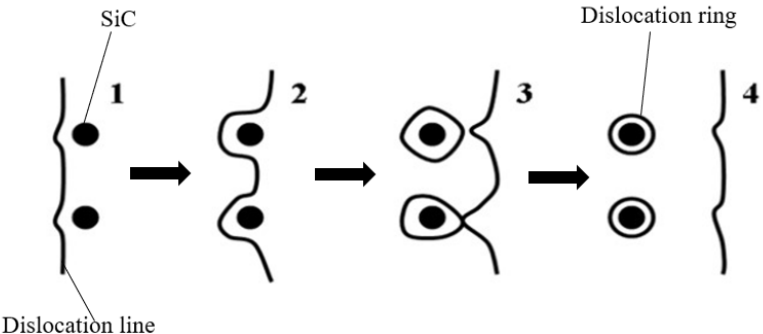
Figure 6. Dislocation bypass mechanism. (Dislocation shift process from 1 to 4)